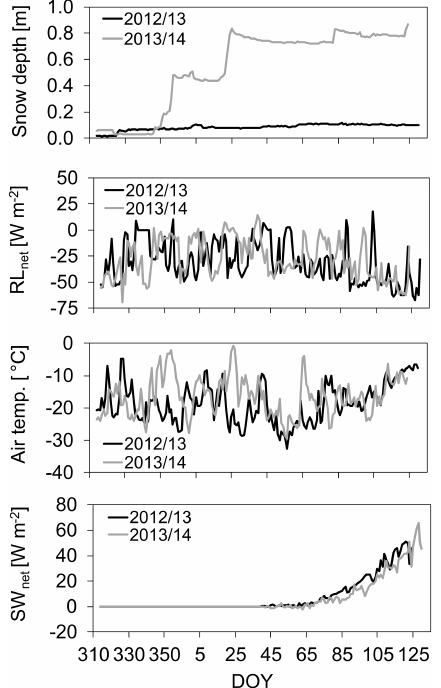
Figure 3. Polar night and pre-melt seasons of the winters 2012/2013 and 2013/2014. Characteristics of snow cover development, air tem- perature, net long-wave radiation (RL net ) and net short-wave radia- tion (SW net ) during the polar night periods and subsequent pre-melt seasons of the winters 2012/2013 and 2013/2014